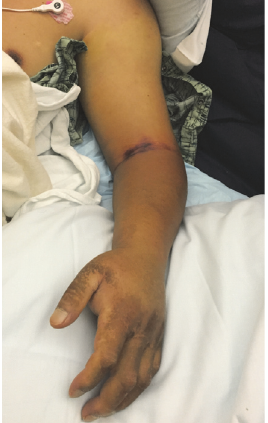
Figure 1: Appearance of the patient’s arm prior to surgery.